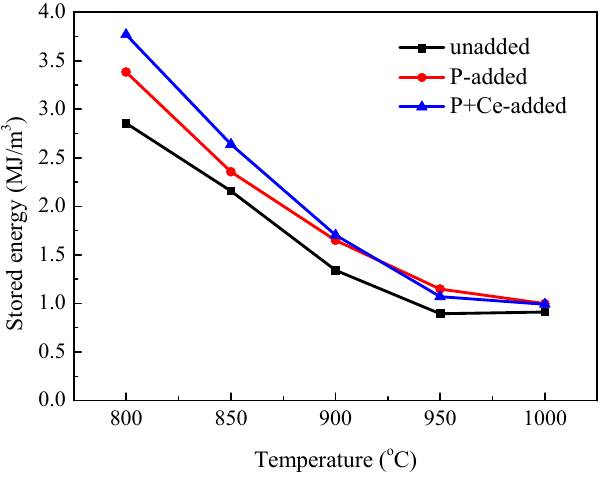
Figure 7. The stored energies in different samples deformed at different temperatures.